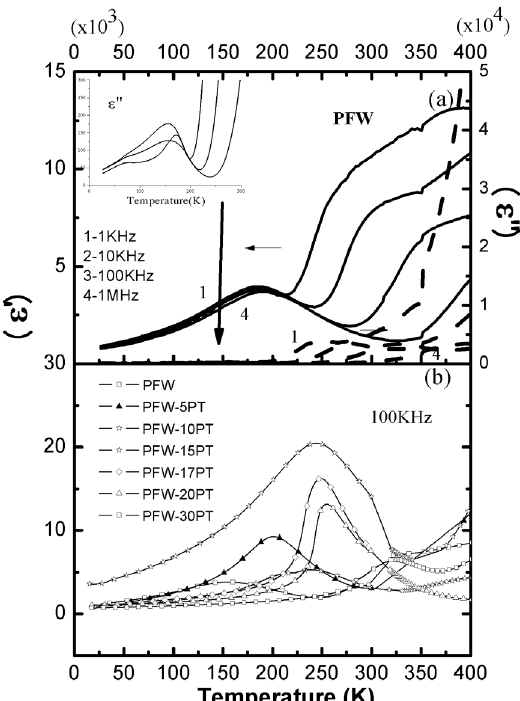
Figure 3. Temperature and frequency dependence of the real ( ε ’) and imaginary ( ε ’’) components of the relative dielectric permittivity of PFW ceramics frequency dependence at various W )O3- x PbTiO solid 2/3 1/3 3